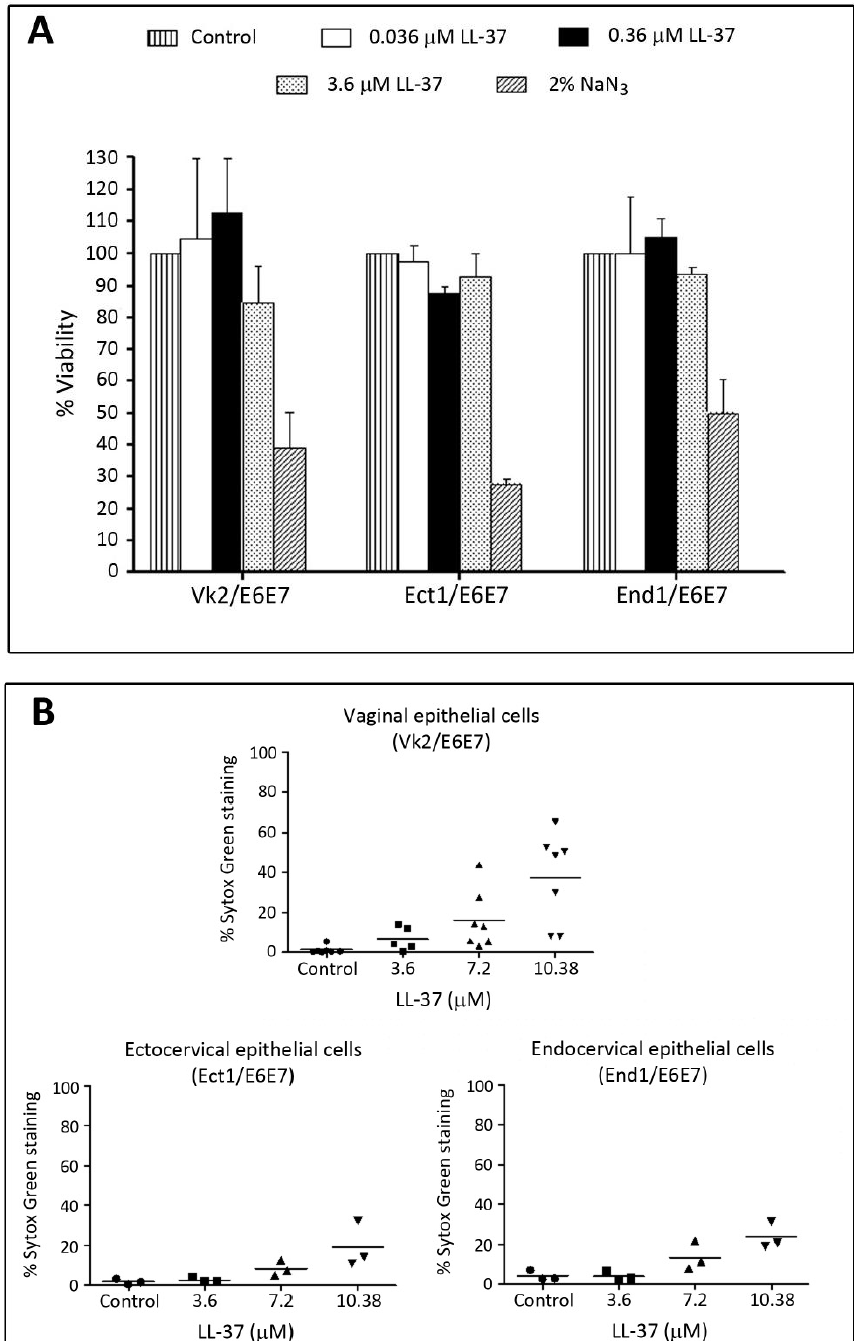
Figure 6. Low adverse effects of LL-37 on human vaginal and cervical cell lines. Vk2/E6E7 (vaginal), Ect1/E6E7 (ectocervical) and End1/E6E7 (endocervical) cells cultured as previously described [123] were treated with various concentrations of LL-37 (24 h, 37 °C, 5% CO 2 ) and subjected to a cytotoxicity MTT assay ( A ) or a membrane intactness assay using Sytox ( B ). ( A ) Treatment of all three cell lines with LL-37 up to 3.7 μM did not change percentages of viable cells. In contrast, the percentages of viable cells were only 50% or less upon treatment with 2% NaN 3 . ( B ) Sytox Green staining was observed in less than 20% of all three cell lines upon treatment with LL-37 up to 3.7 μM. When the LL-37 concentration was increased to 10.8 μM, the numbers of Sytox Green stained cells became higher, although for both End1/E6E7 and Ect1/E6E7 cells, the percentages were still <20%. For Vk2/E6E7 cells, this percentage was 40%.